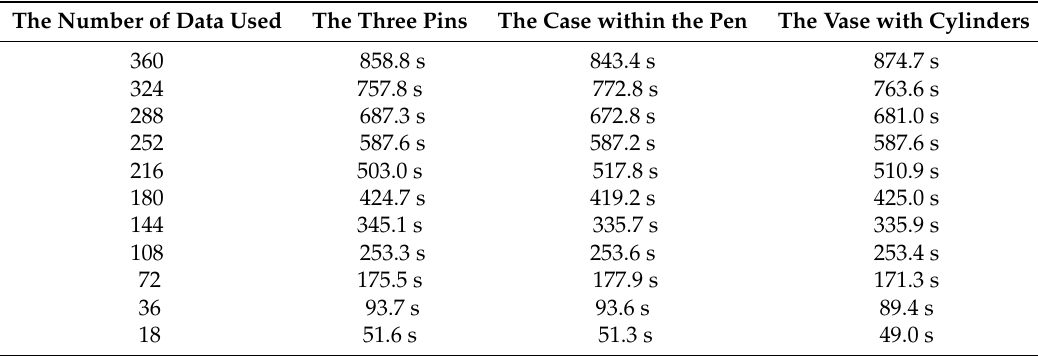
Table 3. Computation time of calculating